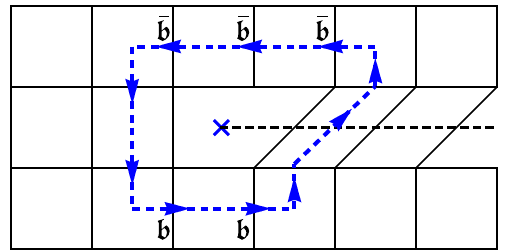
ˆ i dislocation ( T defect) i ; g Þ per unit length, the branch line i ; g Þ . The topological i ; g Þ , which matches the i b ð T a ; g Þ × a (cid:3) . Here, T i ð i g Þ ¼ ½ g defect with a g -defect loop encircling it, x ; g Þ topological charge per directed x ; g Þ labels are left y